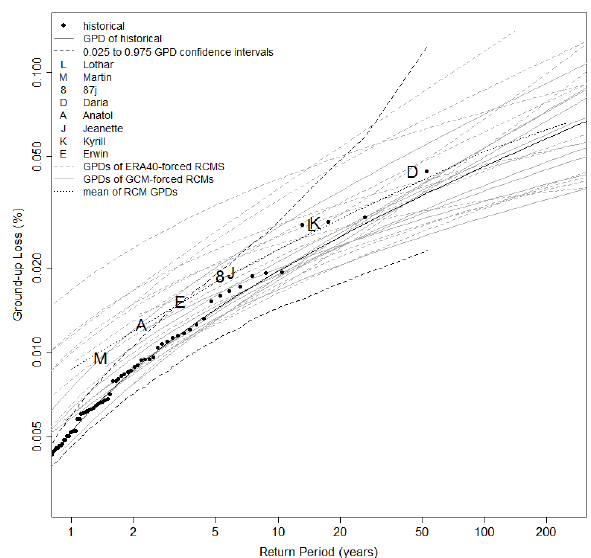
Fig. 5 All-Europe losses for the RCM storm sets using a) the largest 250 storms and b) the largest 109 storms from each RCM. Historical losses are given by black points with some important historical storms represented by letters. GPDs fitted to the individual RCMs are given by the grey lines with their mean (dotted line). The solid black line is the GPD fit through the historical losses, with 95% confidence limits (dashed).